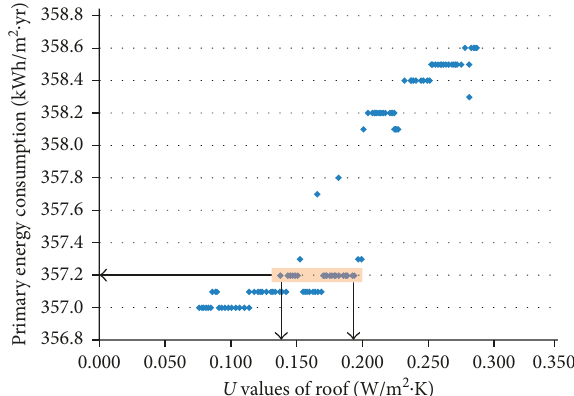
Figure 6: LCC according to the U values of the roofs.